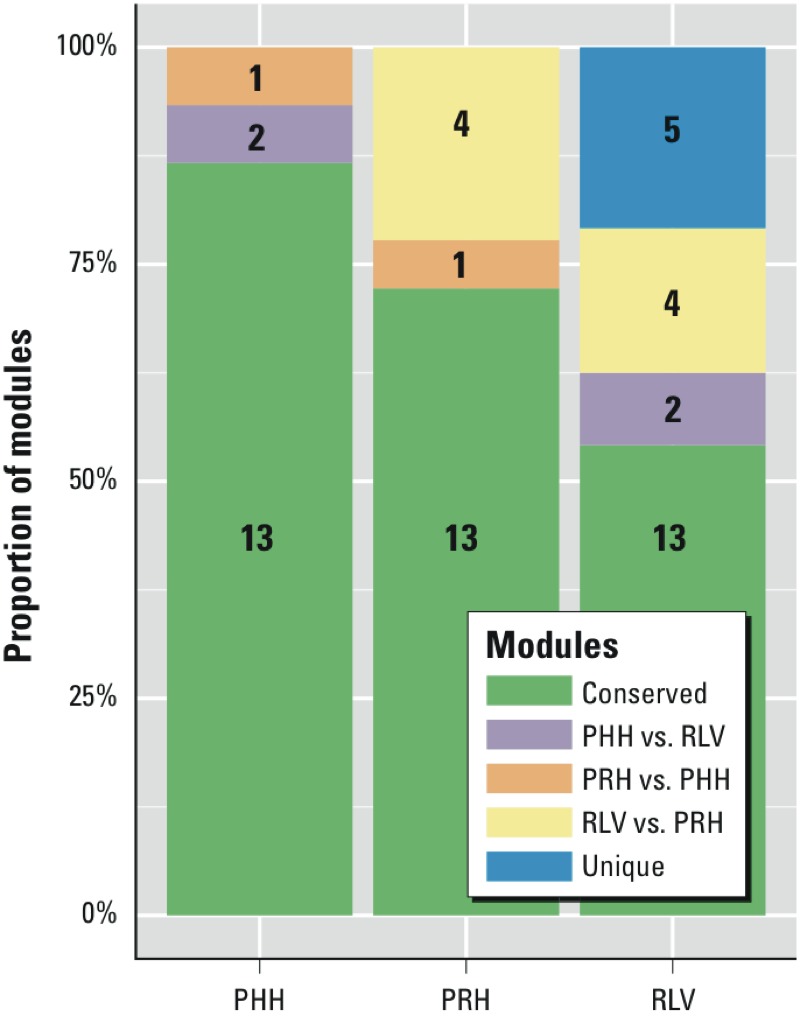
The number of non-redundant transcriptional modules and proportions identified for each and across all experimental settings in TG-GATEs. Each bar corresponds to an experimental setting in TG-GATEs (RLV, PRH, PHH) and contains the number of modules found to be unique for the experiment (blue) or shows a corresponding module in another experiment (see color legend: green for conserved, purple for conserved in RLV vs. PHH, orange for conserved in PHH vs. PRH, yellow for conserved in RLV vs. PRH). Although only a few modules were detected in only one or two settings, most modules showed significantly high overlap in terms of pathway enrichment across all settings (hypergeometric p < 0.001).